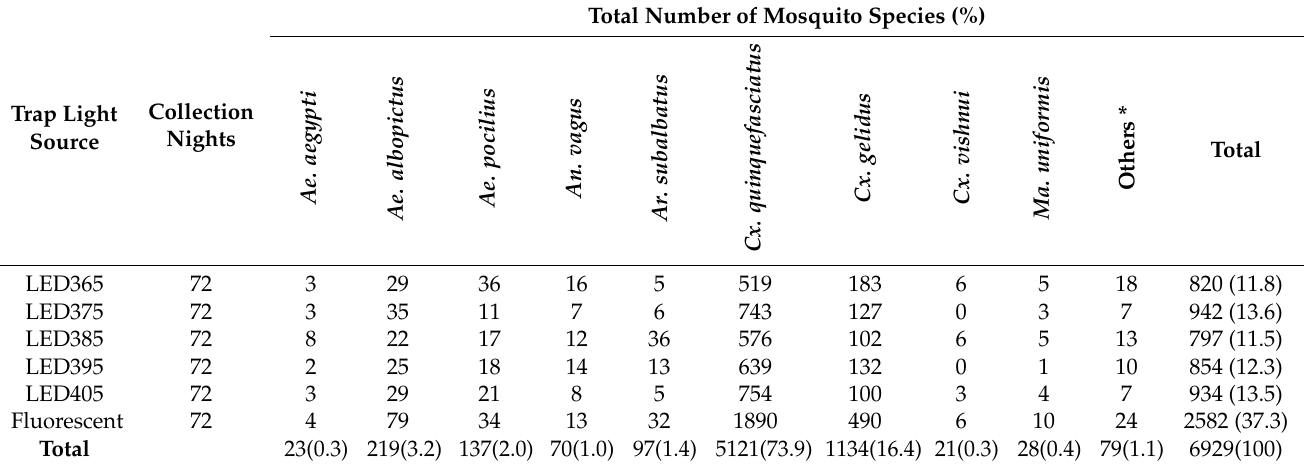
Table 1. Total number and percentage of adult mosquito species captured in traps with 6 different light sources over 6 replications (6 nights/replication) in dry and wet seasons at Kasetsart Univer- sity, Bangkok.